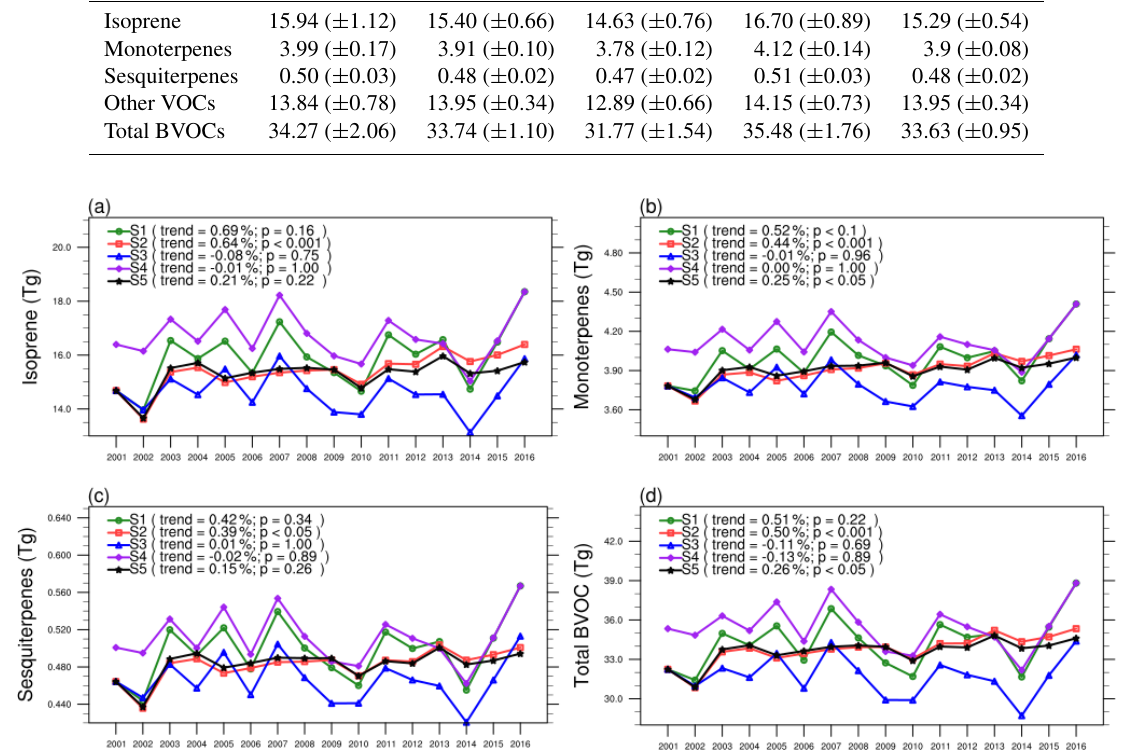
Figure 4. Annual BVOC emissions in China from 2001 to 2016 for five scenarios (S1–S5) described in Table 1. The increasing trends and the probabilities ( p ) using the Mann–Kendall test are shown in the